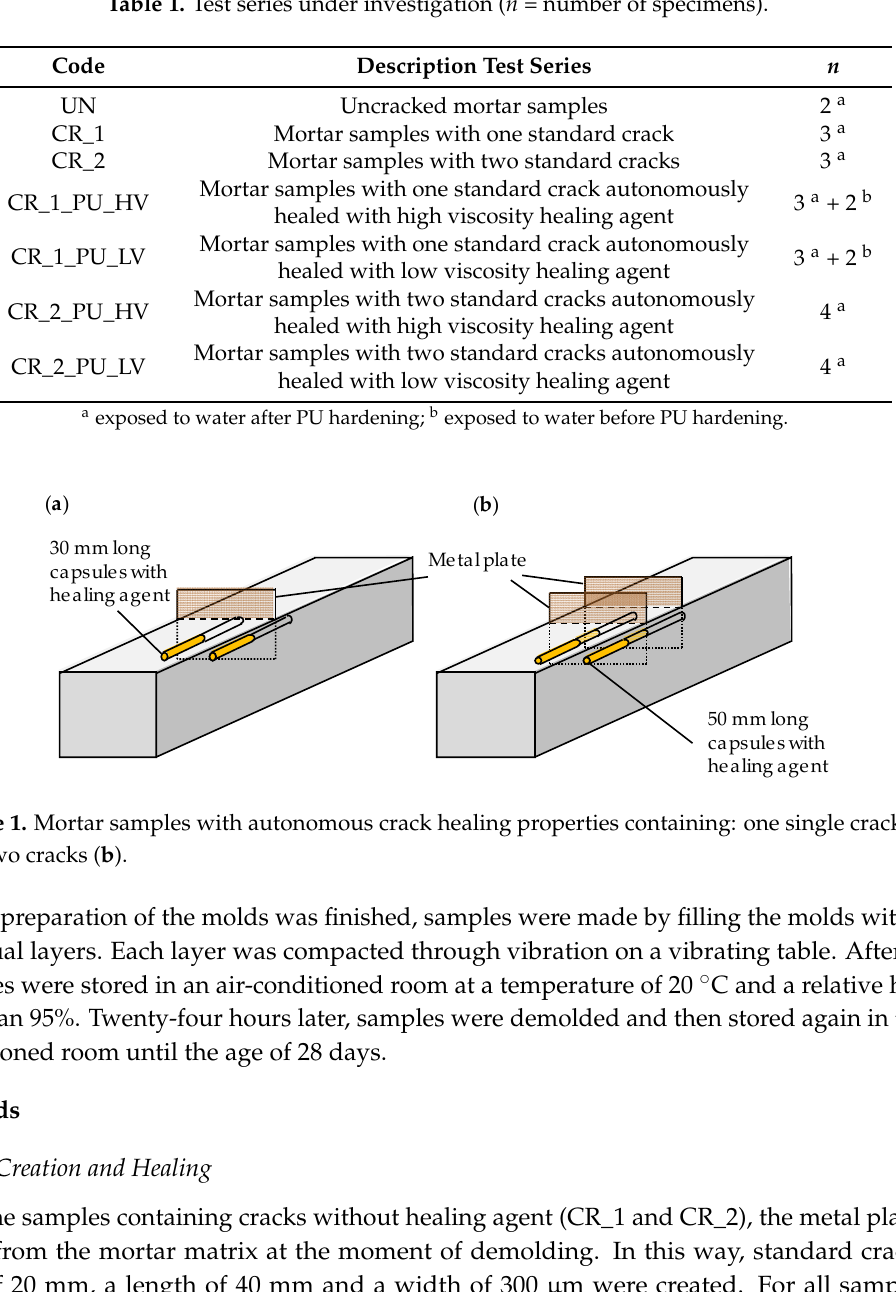
Table 1. Test series under investigation ( n = number of specimens).